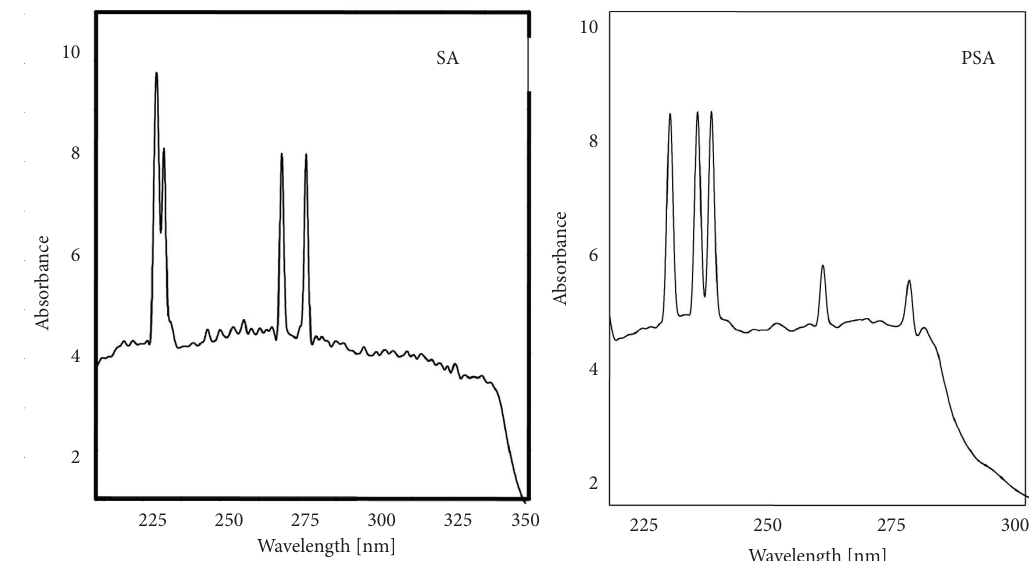
Figure 7: UV assignments of SA and PSA.